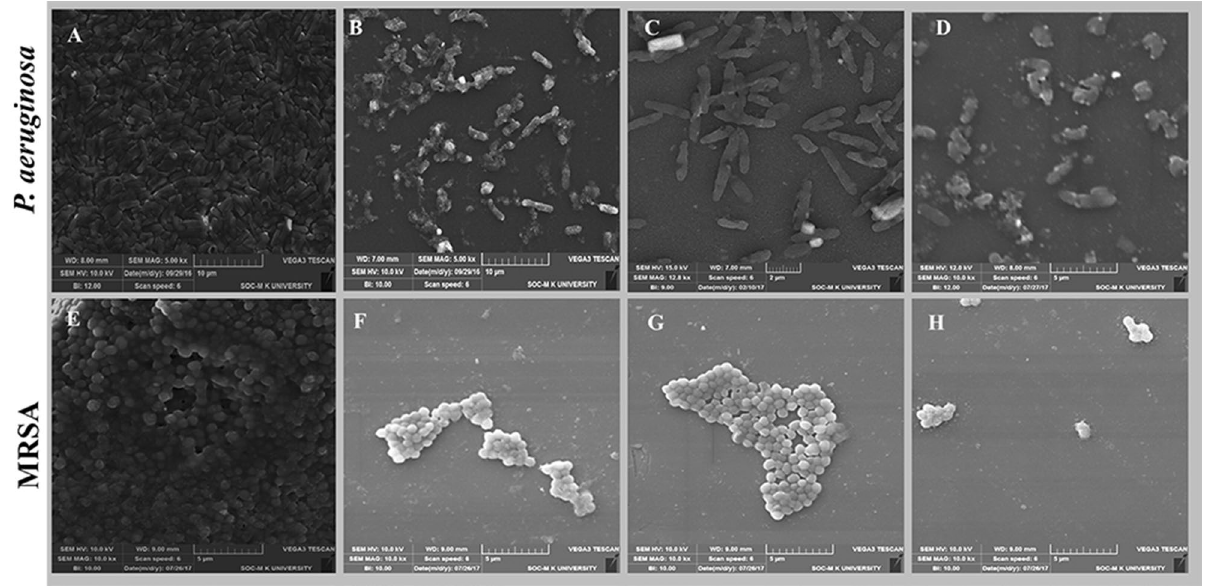
Figure 13. SEM images of P.aeruginosa and MRSA biofilms with treatment combinations. ( A , E ) Control biofilms without treatment, ( B , F ) Biofilms treated with LP alone, ( C , G ) Biofilms treated with Cu-NPs alone, ( D , H ) Biofilms treated with LP + Cu-NPs.